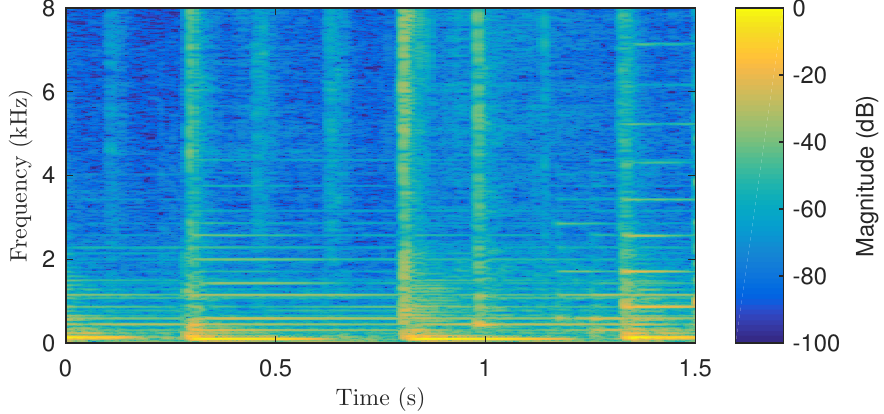
Figure 1. Spectrogram of a signal consisting of piano, percussion, and double